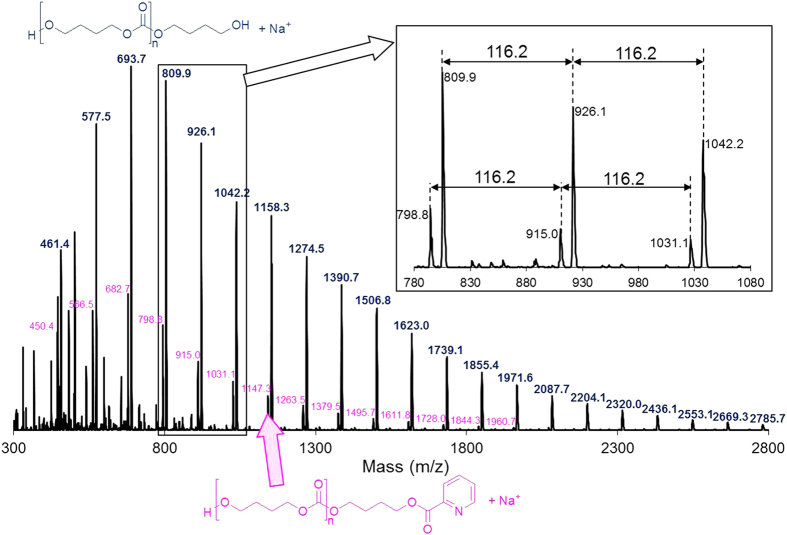
MALDI-TOF mass spectrum of the products from CO2 and 1,4-butanediol using CeO2 and 2-cyanopyridine.